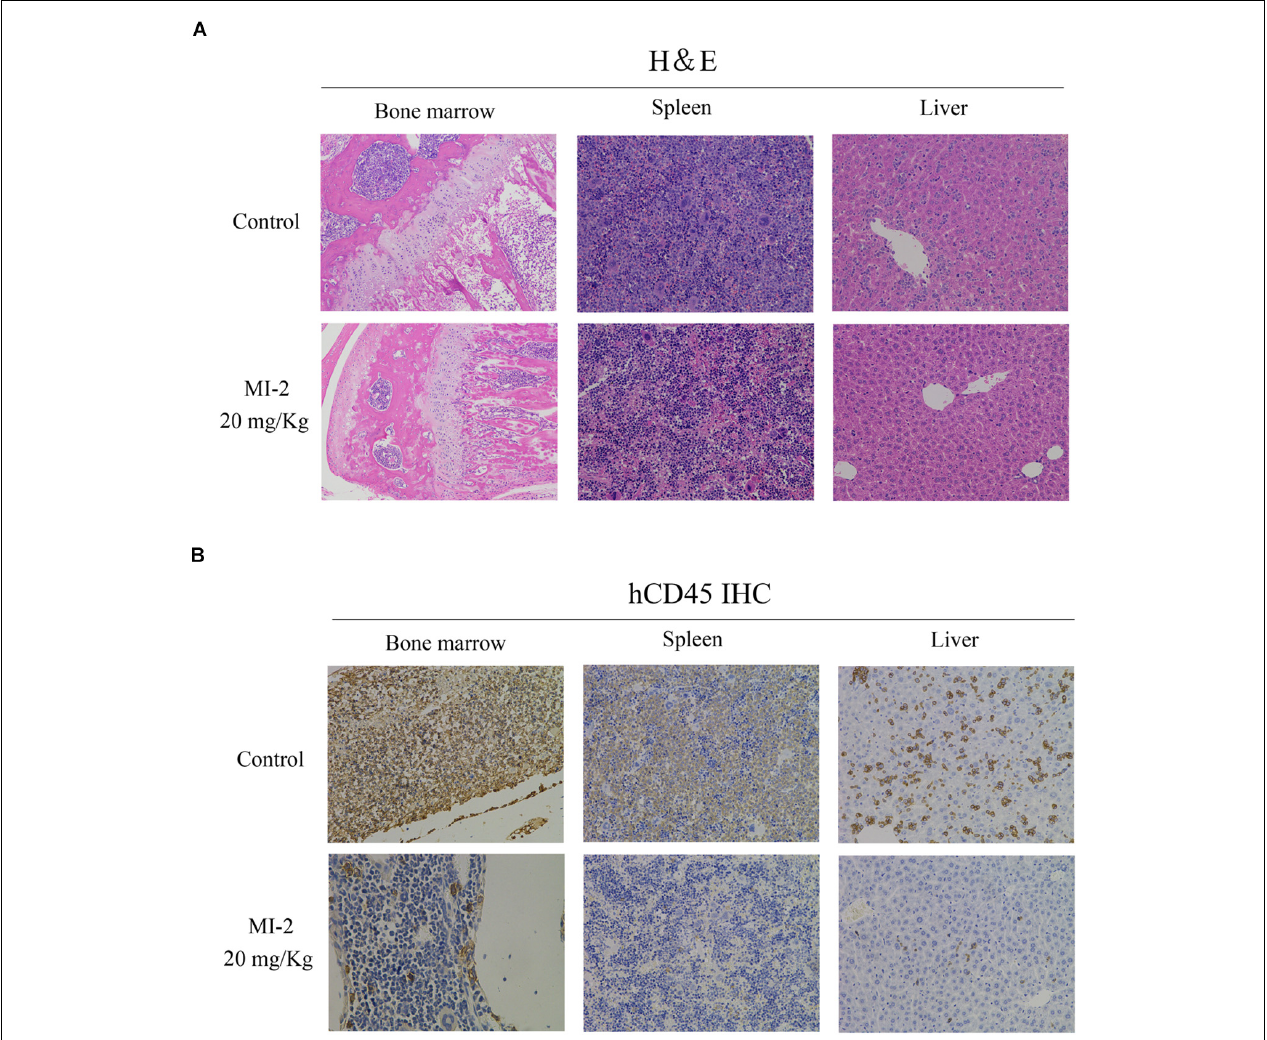
FIGURE 5 | The pathological morphologies of mouse tissues. (A) Hematoxylin-eosin staining for the indicated tissues in animals treated with control or MI-2. (B) Immunohistochemistry staining of CD45 positive cell in the BM, spleen and liver of control and MI-2